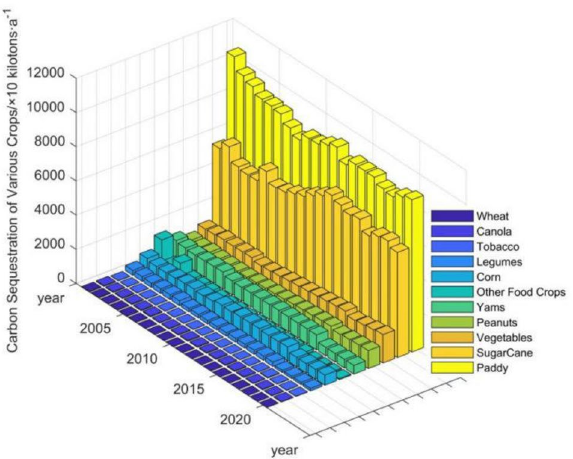
Figure 5. Comparison of carbon sequestration by various crops in Guangdong farmland ecosystems.